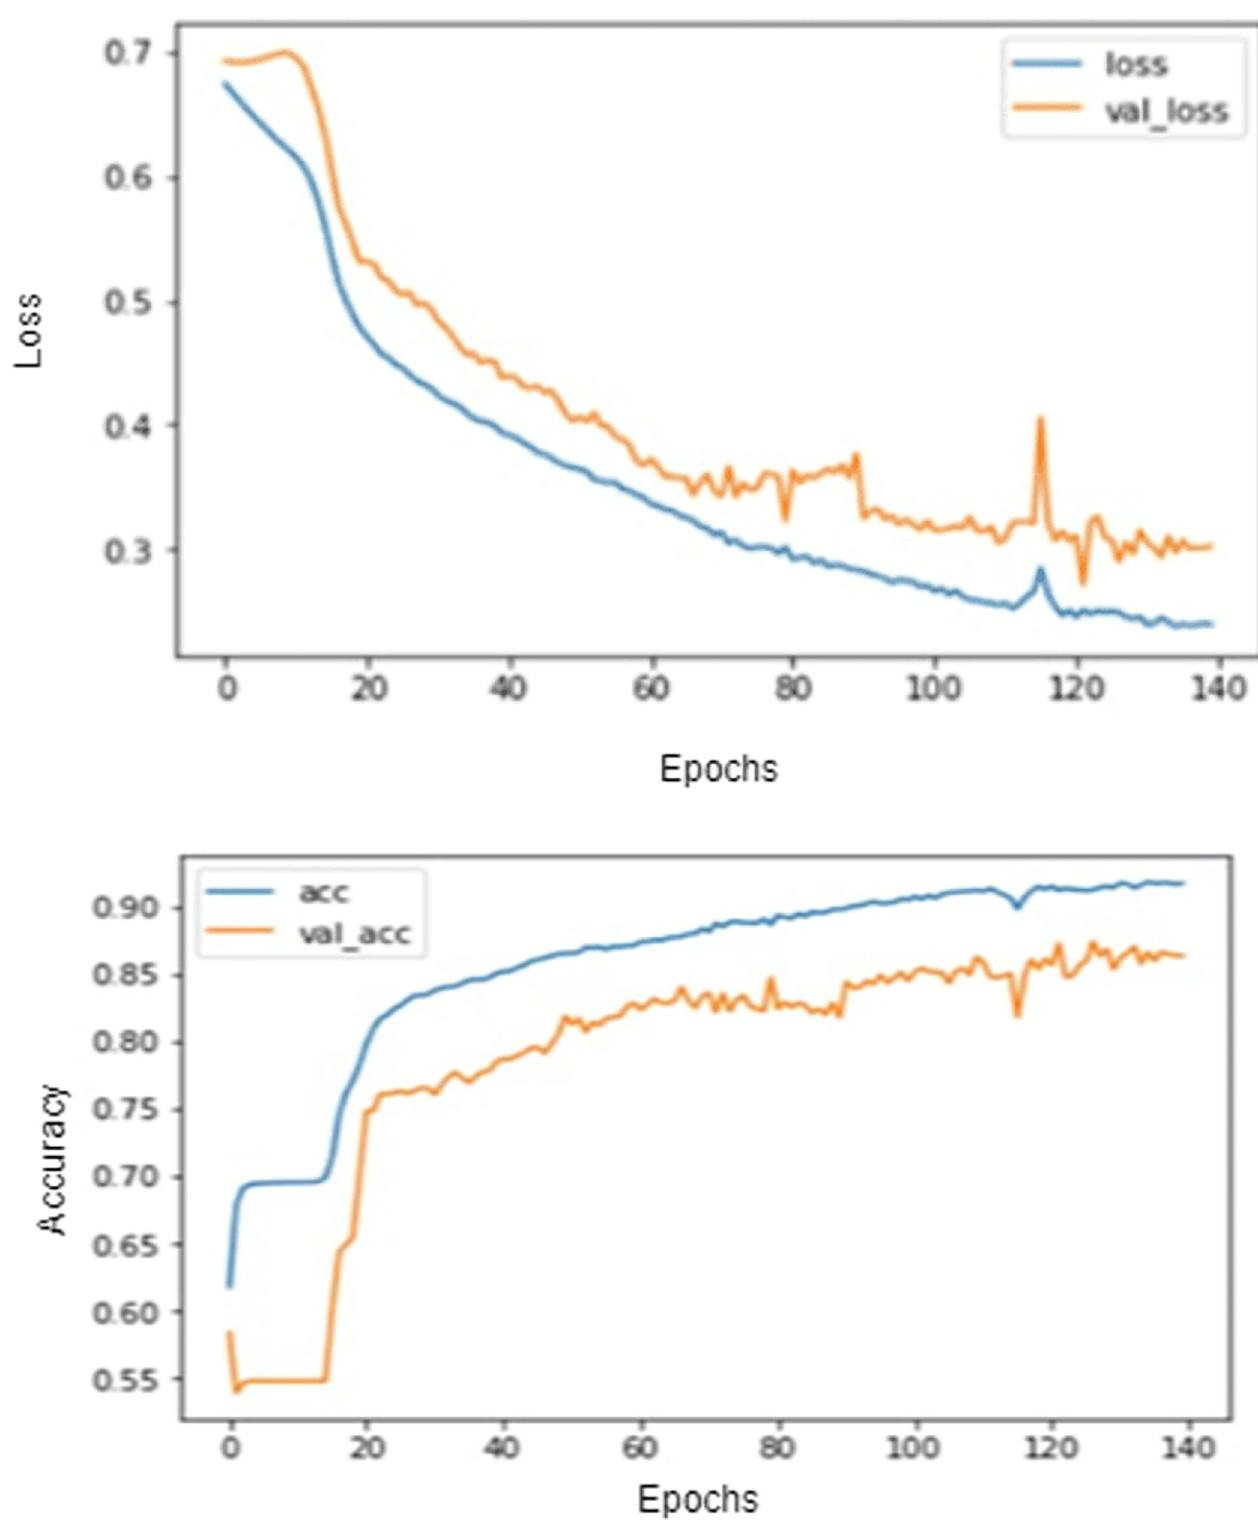
Fig 5. Graphs for Training and validation for RNNCON-Res. (a) loss (b) accuracy.